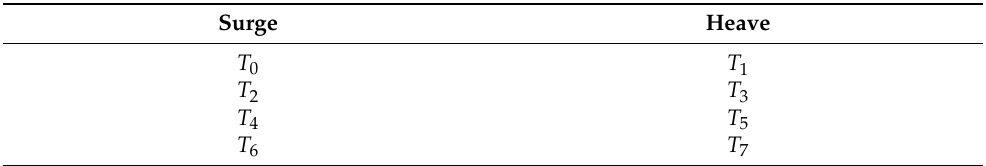
Table 1. UX-1 optimal thrusters used according to the movement direction, if one thruster is disabled the system must adapt to use the remaining thrusters in the